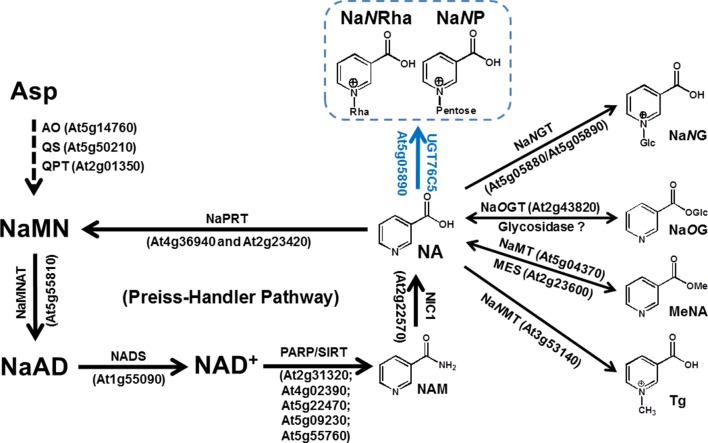
NAD Metabolism and Nicotinate Conjugations in Arabidopsis thaliana. The reaction catalyzed by UGT76C5 and its products, NaNP (nicotinate N-pentoside) and NaNRha (nicotinate N-rhamnose), are highlighted. The genes, which encode characterized enzymes in Arabidopsis, are also indicated. Abbreviations: AO, aspartate oxidase; MeNA, methyl nicotinate; MES, methylesterase; NA, nicotinate; NaAD, nicotinate adenine dinucleotide; NAD, nicotinamide adenine dinucleotide; NADS, NAD synthase; NAM, nicotinamide; NaMN, nicotinate mononucleotide; NaMNAT, NaMN adenylyltransferase; NaMT, nicotinate methyltransferase; NaNMT, nicotinate N-methyltransferase; NaOG, nicotinate O-glucoside; NaOGT, nicotinate O-glucosyltransferase; NaNG, nicotinate N-glucoside; NaNGT, nicotinate N-glucosyltransferase; NaPRT, nicotinate phosphoribosyltransferase; NIC1, nictinamidase 1; PARP, poly(ADP-ribose) polymerase; QPT, quinolinate phosphoribosyltransferase; QS, quinolinate synthase; SIRT, sirtuins (NAD dependent protein deacetylases); Tg, trigonelline.